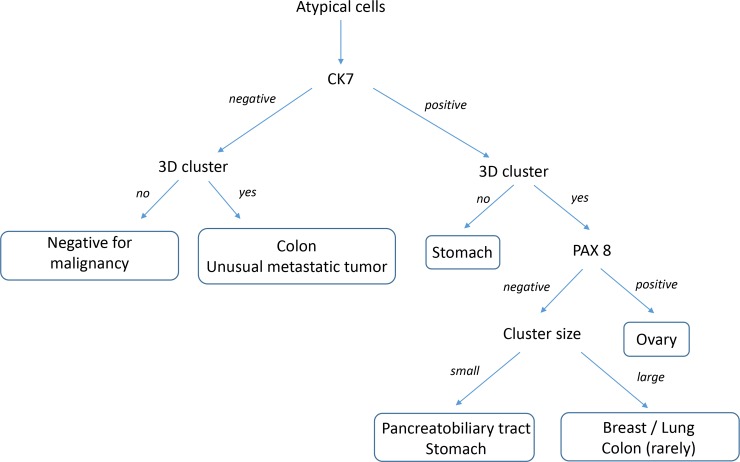
Diagnostic decision tree for peritoneal fluid cytology utilizing cellular cluster and immunocytochemistry patterns to identify primary cancers which have metastatized to peritoneal fluids.